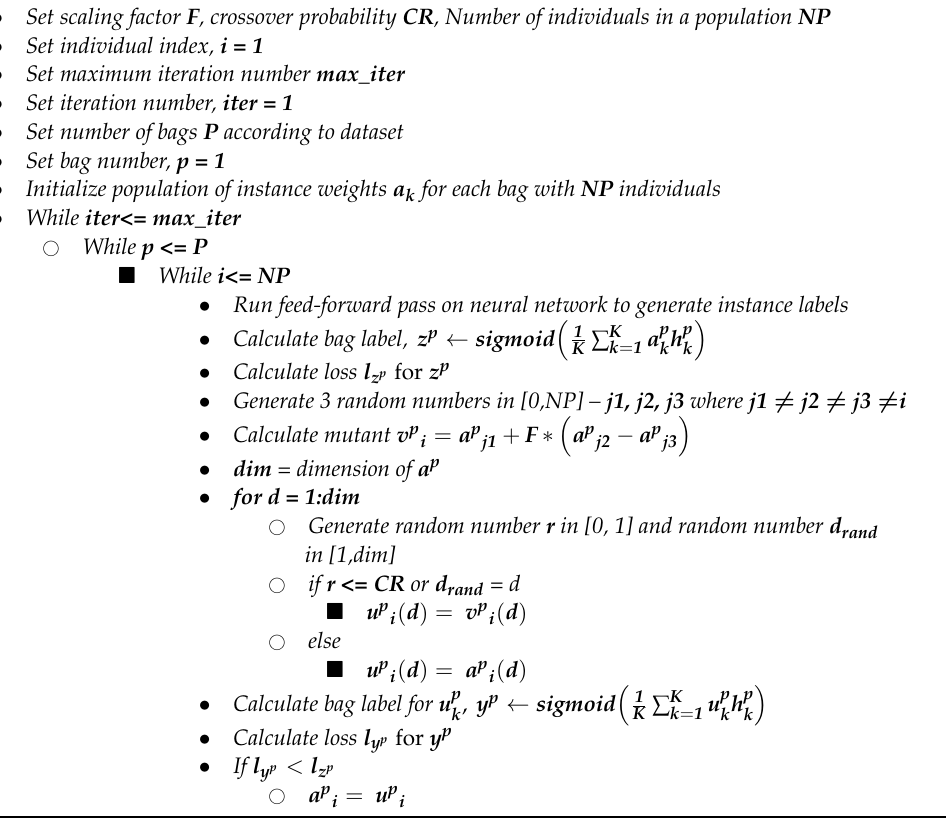
Algorithm 1. MIL Pooling Function using